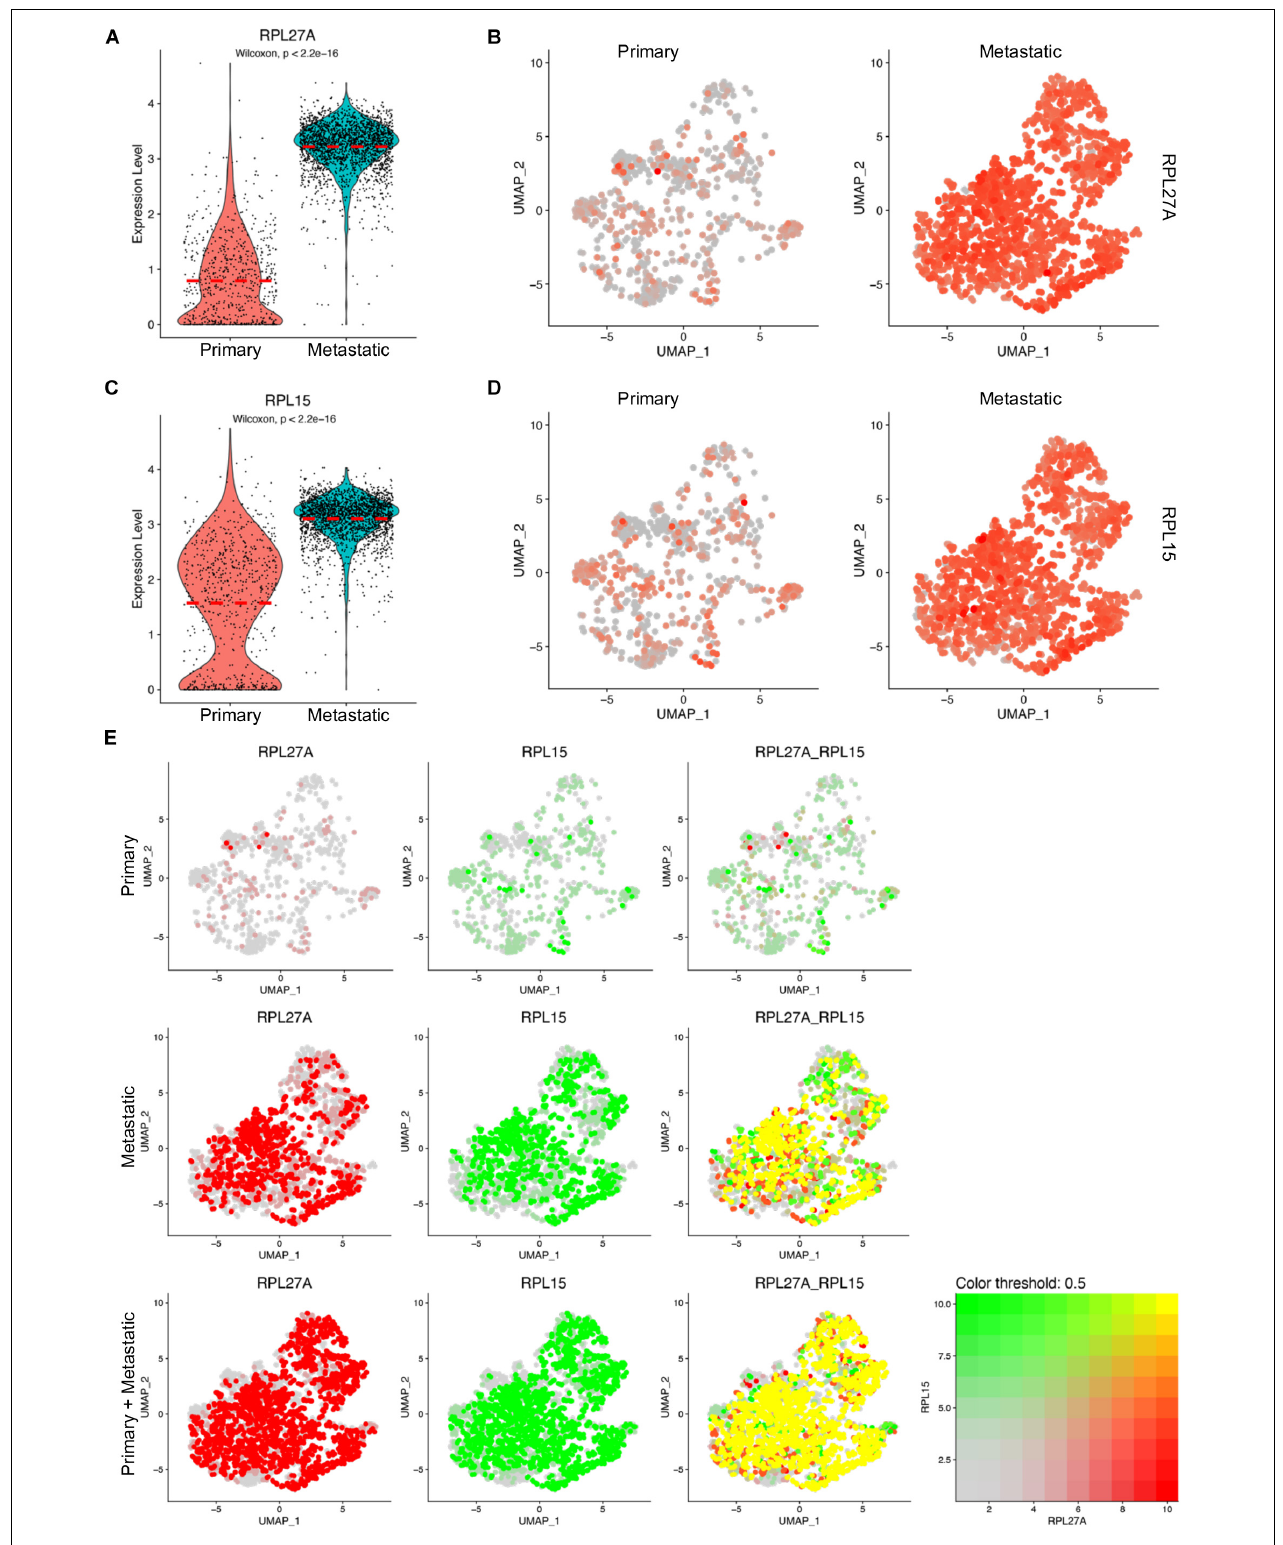
FIGURE 4 | Upregulated RPL27A and RPL15 in metastatic TNBC cancer cells. (A,C) Violin plot representing the expression of RPL27A (A) and RPL15 (C) in primary and metastatic TNBC cancer cells. (B,D) UMAP confirmation of RPL27A (B) and RPL15 (D) expression in primary and metastatic TNBC cancer cells. (E) Colocalization of RPL27A and RPL15 transcription in the integrated TNBC cancer cells, primary TNBC cancer cells, and metastatic TNBC cancer cells.